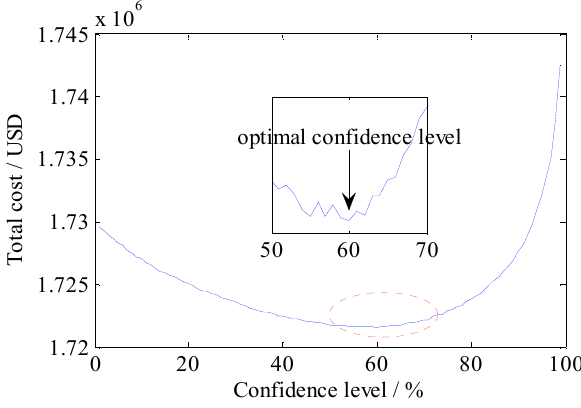
Figure 8. Total cost under different confidence levels for 118-bus system (Case 2).